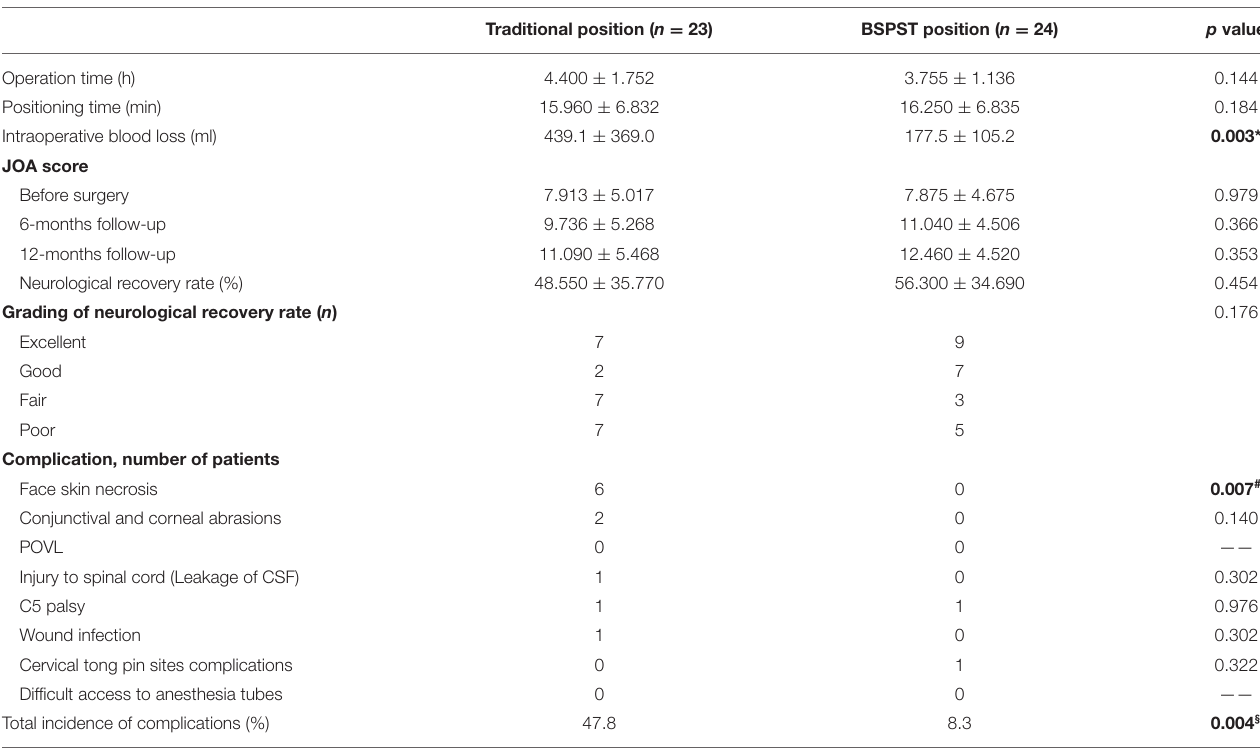
TABLE 2 | Comparisons in outcomes and complications between two groups.